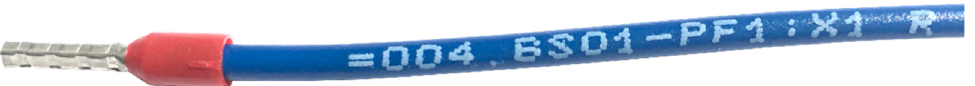
Figure 3. The result of the fully automated preproduction of unique wire with exact length, appropriate end ferrule, and marking (label).